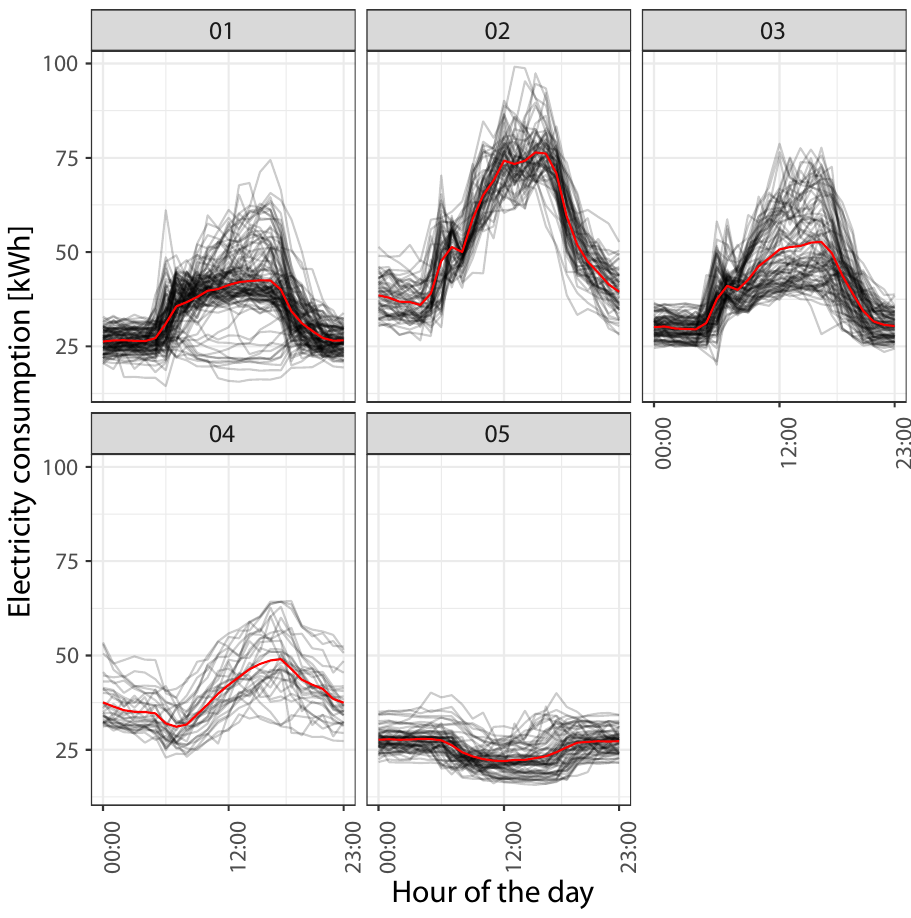
Figure 9. Recurrent daily load profiles identified for the building Rat_health_Gaye .